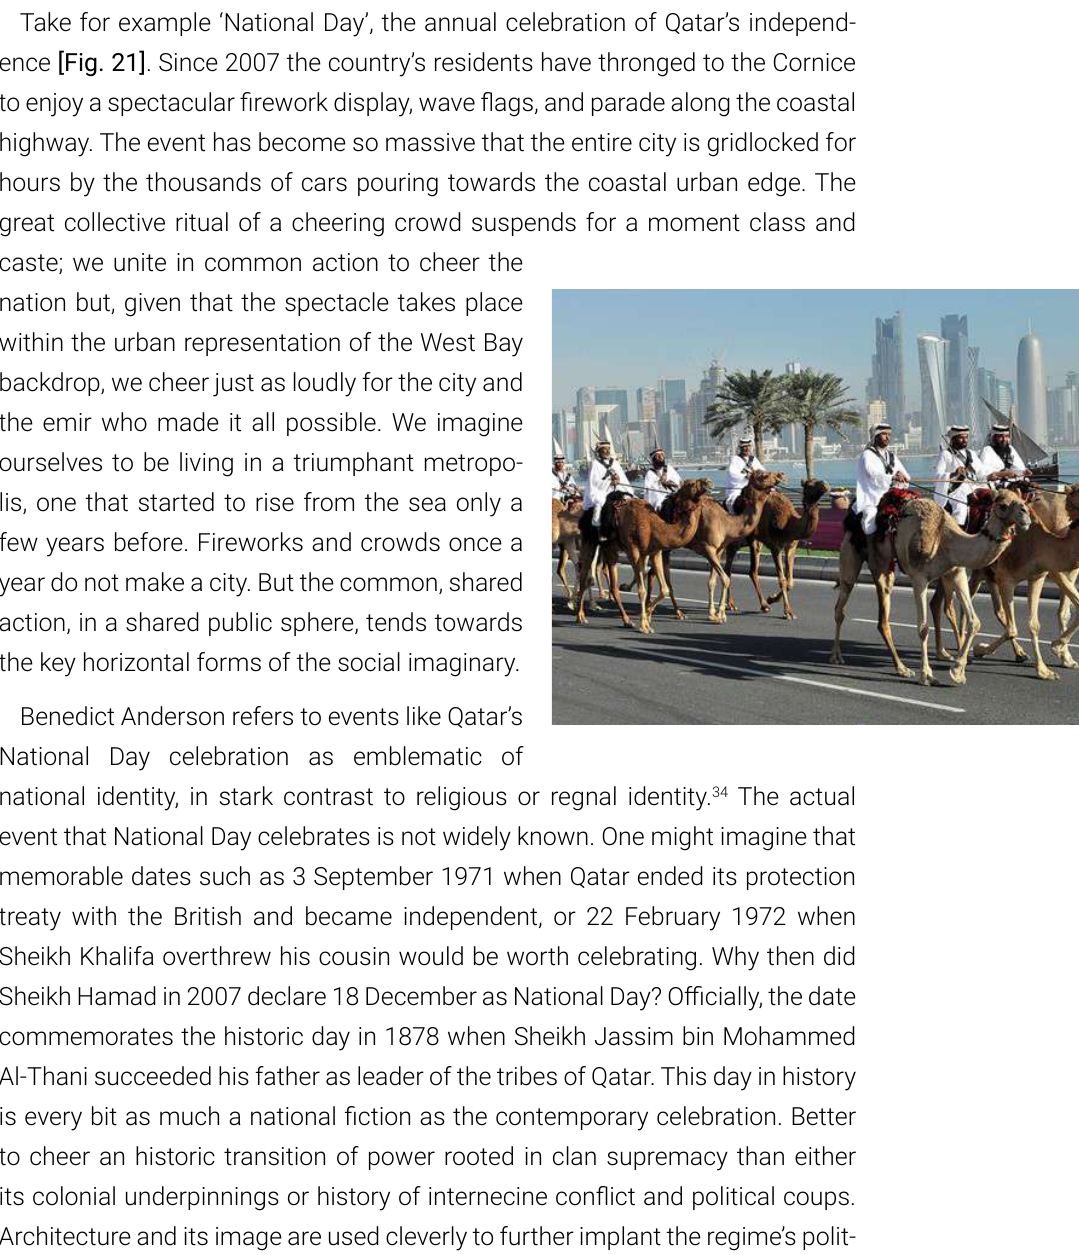
National Day Parade (Source: Al Jazeera News,